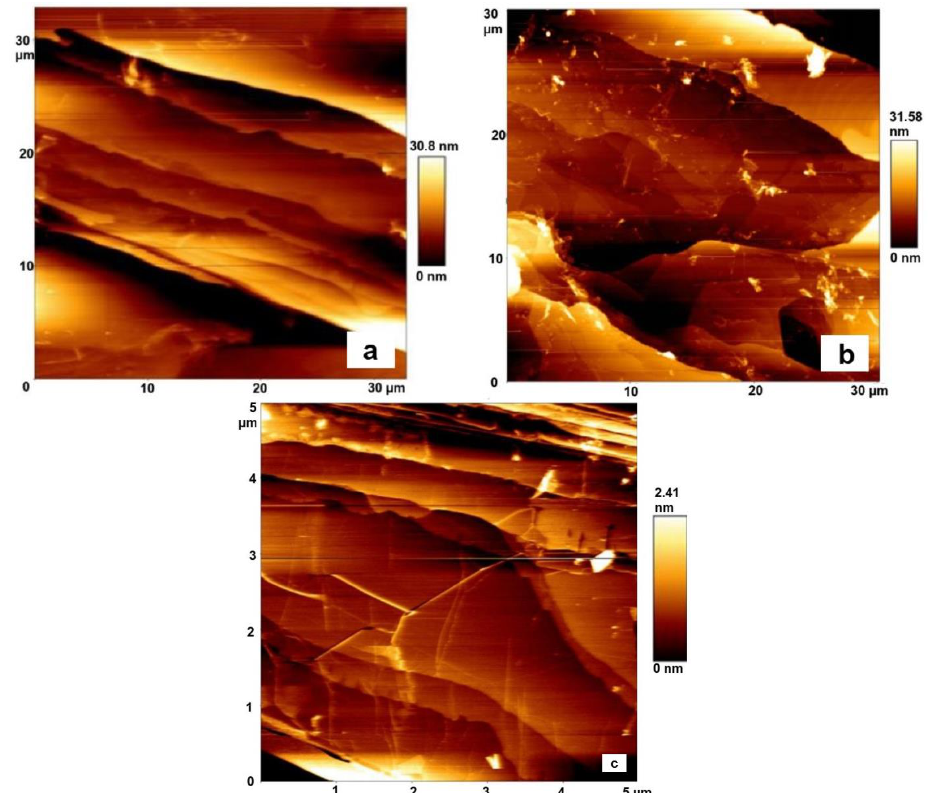
Figure 4. ( a ) Overview of the superstructure in the sample StGr-5. Bunched steps occur in periodic distances of about 15–20 µ m to each other with step heights up to 20 nm. Smaller steps (medium range steps) do have approximately one fifth of both the step height and the distance compared to the superstructure. For yet smaller features, a higher magnification is necessary; ( b ) The same superstructure is visible in the other sample, StGr-7, but the medium range structure follows a more random order here. On top of the medium-range steps, small-range structures are faintly visible; ( c ) 5 × 5 µ m 2 image showing a section of the graphitized surface of the sample StGr-5. Several steps can be seen with several growth fronts that all face towards the bottom-left of the picture. This structure is the fine-structure that can be found in between the bunched steps and m-steps which are displayed in ( a , b ). Over the visible terraces, two kinds of separations may be visible. The first is a distinctive set of lines, standing out about 1 nm from the mean height of the terrace. These lines often form 120 ◦ angles and cross small-range and medium-range steps in an undisturbed manner while being typically oriented at high angles to them. The second set of lines is less pronounced and never shows more than 0.6 nm difference in height to the surroundings. Typically, they are at very high angles close to 90 ◦ to small-range steps, where they often stop. These lines never cross medium-range